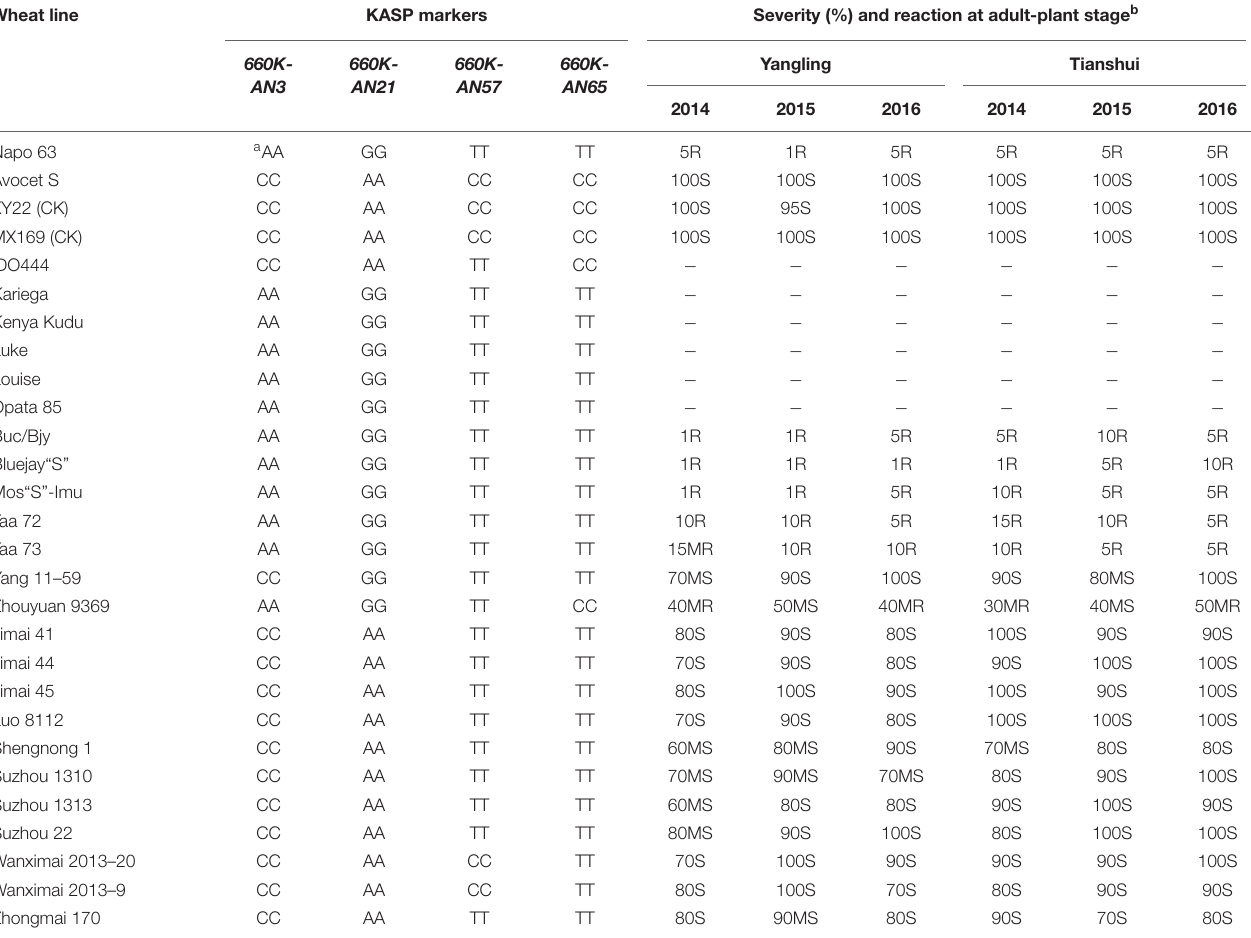
TABLE 4 | Phenotype and alleles of KASP markers flanking Qyrnap.nwafu-2BS in Napo 63, Avocet S (AvS), susceptible checks and 19 wheat cultivars and landraces. Wheat